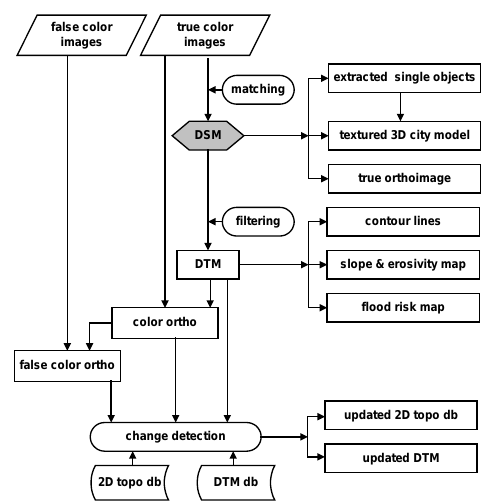
Figure 4. New mapping products and their generation